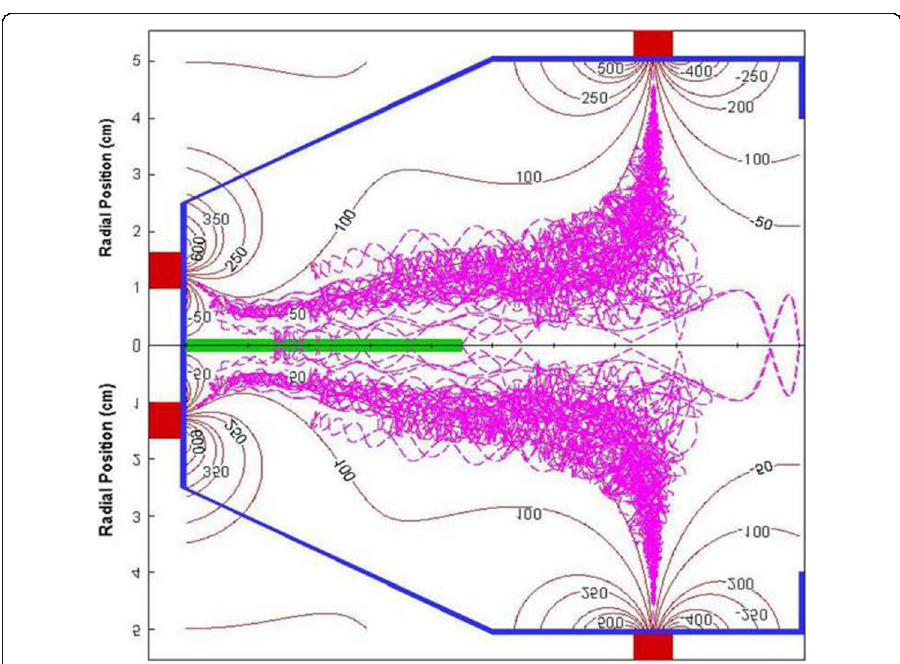
Fig. 10 Charge particle trajectory in an Hall effect ion thruster